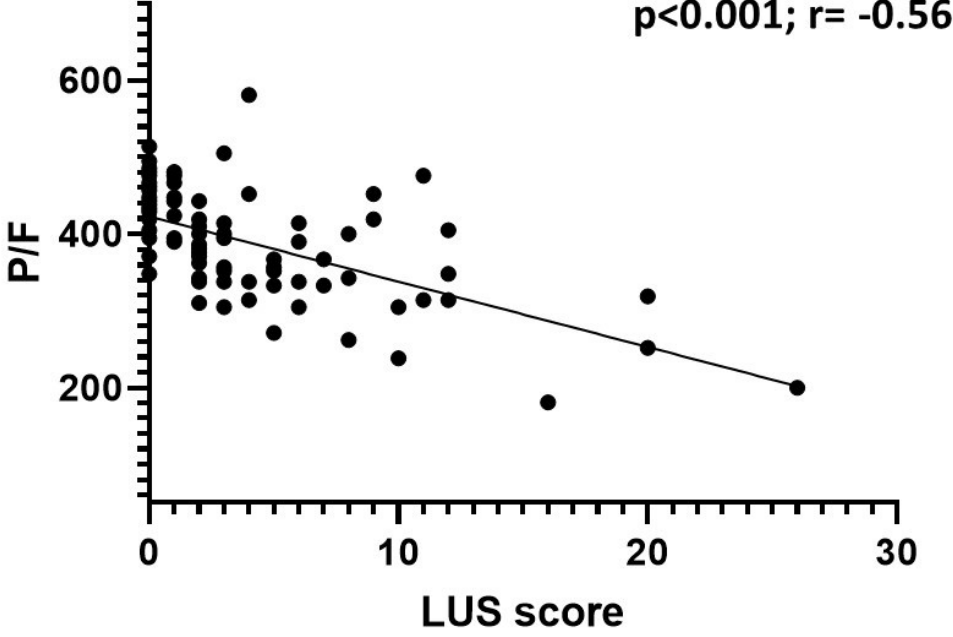
Figure 4. Correlation between LUS score and P/F ratio in COVID-19 patients. The data show a statistically significant inverse correlation.